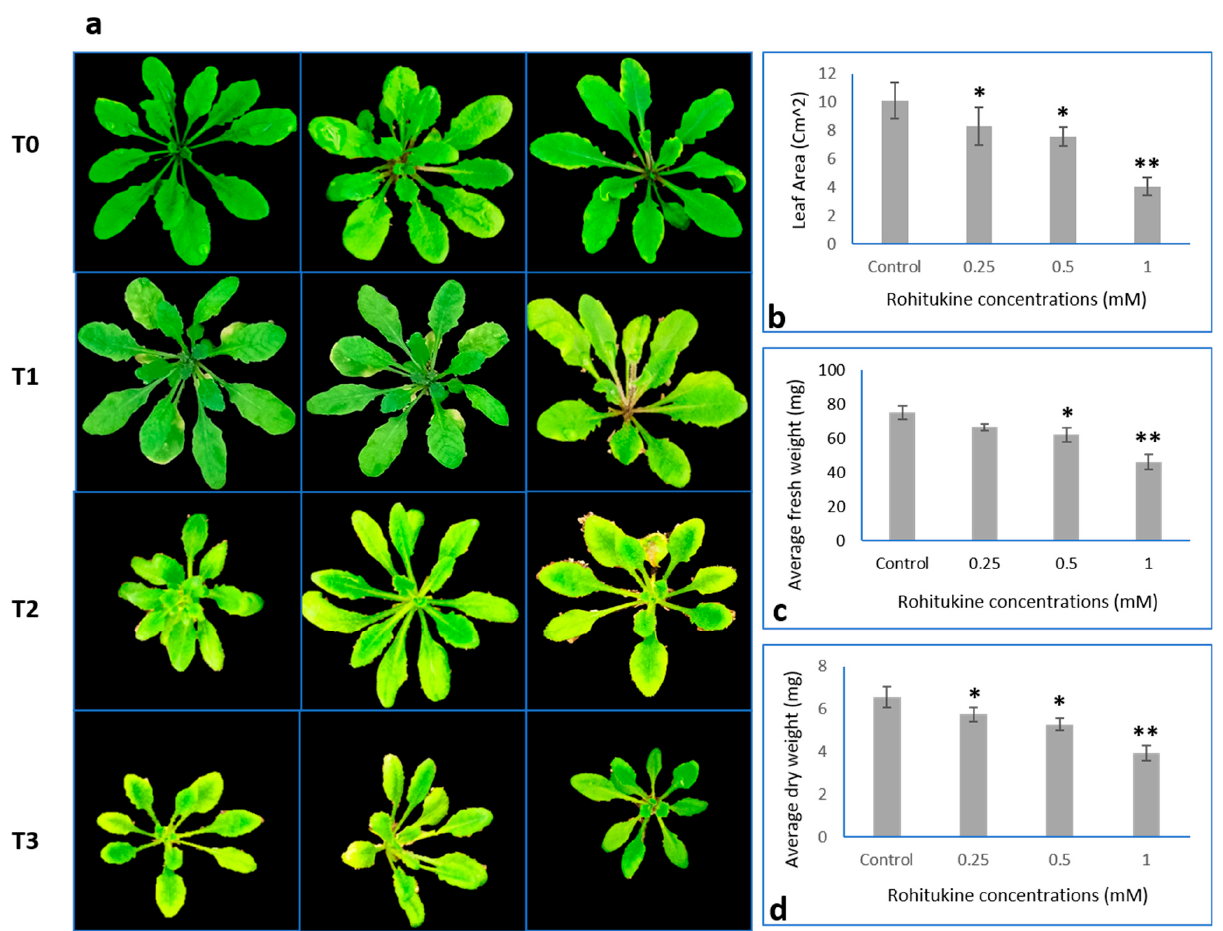
Figure 3. Morphology of A. thaliana plants treated with T0 (Control), T1 (0.25 mM), T2 (0.5 mM) and T3 (1.0 mM) rohitukine concentrations. ( a ) Five-week-old A. thaliana plants with and without rohitukine treatment. ( b ) Effects of 0.25 mM, 0.5mM and 1mM Rohitukine on leaf area of A. thaliana plants. ( c ) Average fresh weight of plants. ( d ) Effect of 0.25 mM, 0.5mM and 1mM Rohitukine on the dry weight of A. thaliana. The results are the means of more than three replicates expressed as means ± SD values. Statistical significance was determined by Student’s t -test. Asterisks * and ** denote the significance level of values at p -values < 0.5 and 0.05,